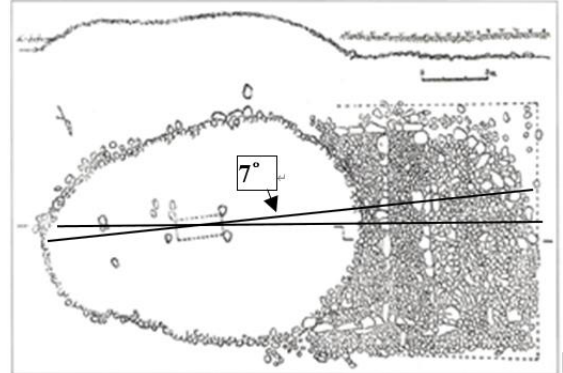
Fig.12 A plan of Unpyonri District 4 No. 6